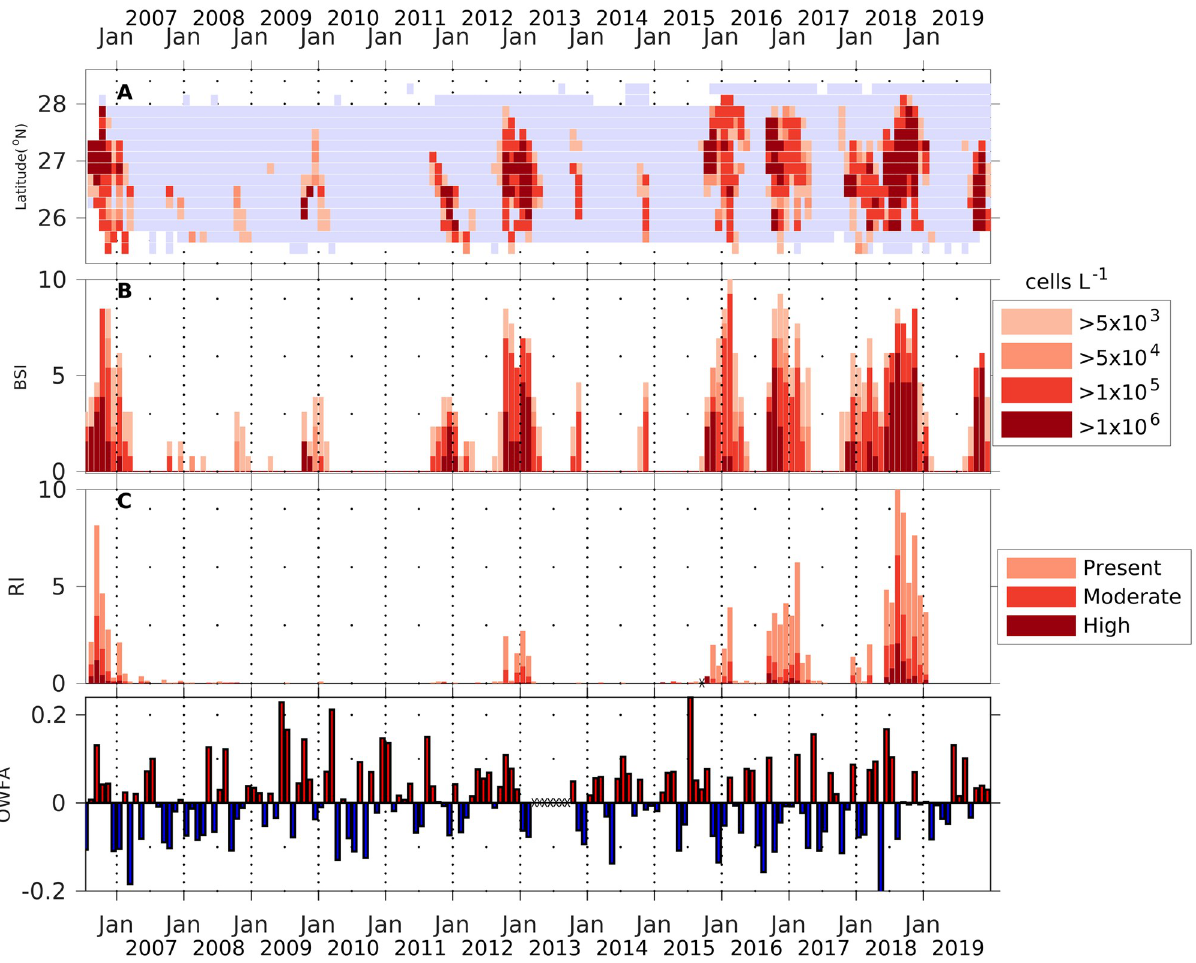
Fig 10. Comparison of binned monthly maximal bloom concentration, bloom severity index, respiratory index, and monthly wind frequency anomalies for 2006 to 2019. The figure covers the period of the respiratory irritation data set. (A) Hovmo¨ller diagram for the monthly maximal K . brevis cell counts in each 0.2˚ latitudinal bin. (B) Monthly bloom severity index for the bloom year (August to July). (C) shows the monthly respiratory index for Manatee and Sarasota counties. (D) Monthly onshore wind frequency anomalies (OWFA) for Station VENF1 (Venice Pier, Florida), with positive values (more frequent onshore wind) marked in red and negative values (less frequent onshore wind) marked in blue. Markers for the years are for January 1. Descriptions are the same as Figs 6 and 9. Black Xs on X-axis during 2013 in the OWFA indicate no wind records were available.